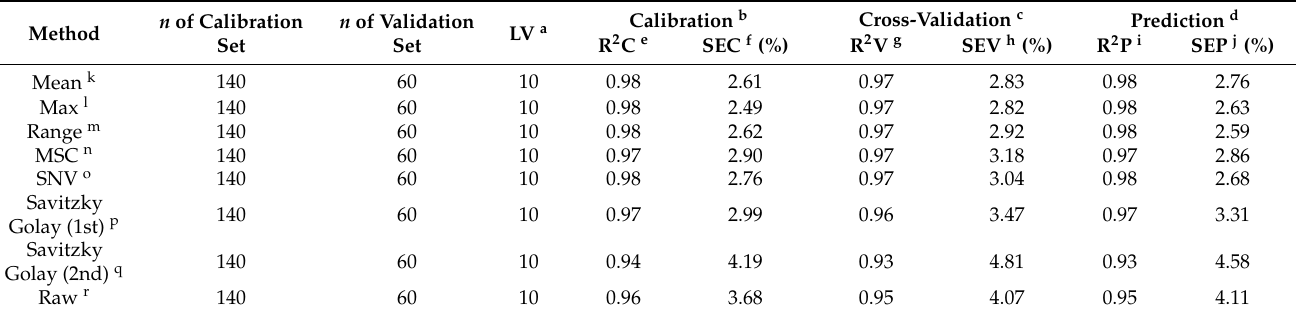
Table 1. Results obtained with global PLSR model for prediction of moisture content in multiple by-products.